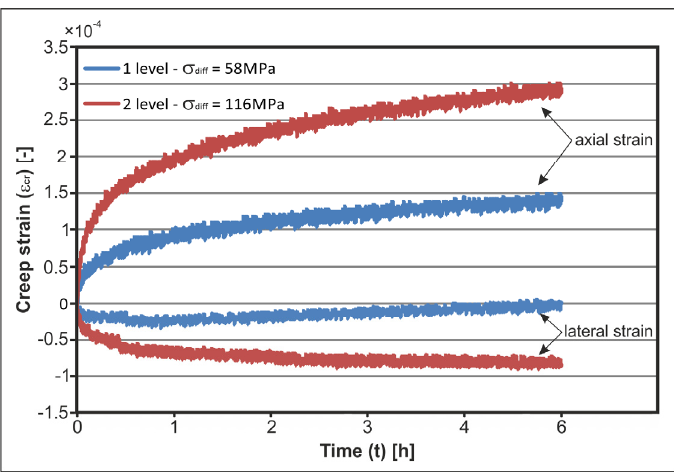
Figure 12 . Axial and lateral strain for sample W-264-B. Figure 12. Axial and lateral strain for sample